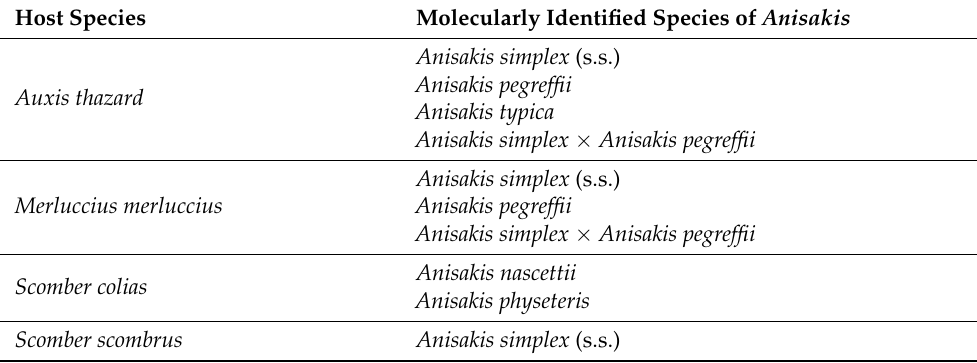
Table 2. List of species of fish infected and Anisakis species